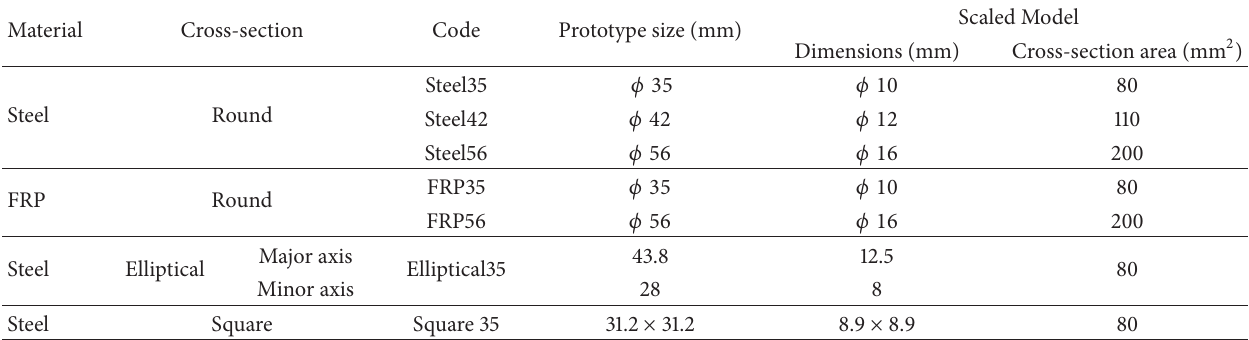
Table 4: Material, cross-section, and size of